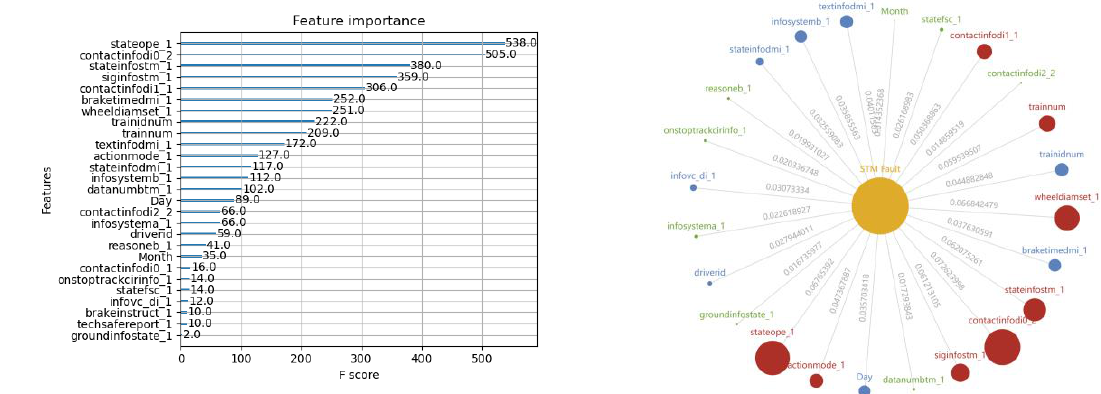
Figure 10. Results of XGBoost training using CGAN-enhanced 2018-T(C) sample set.